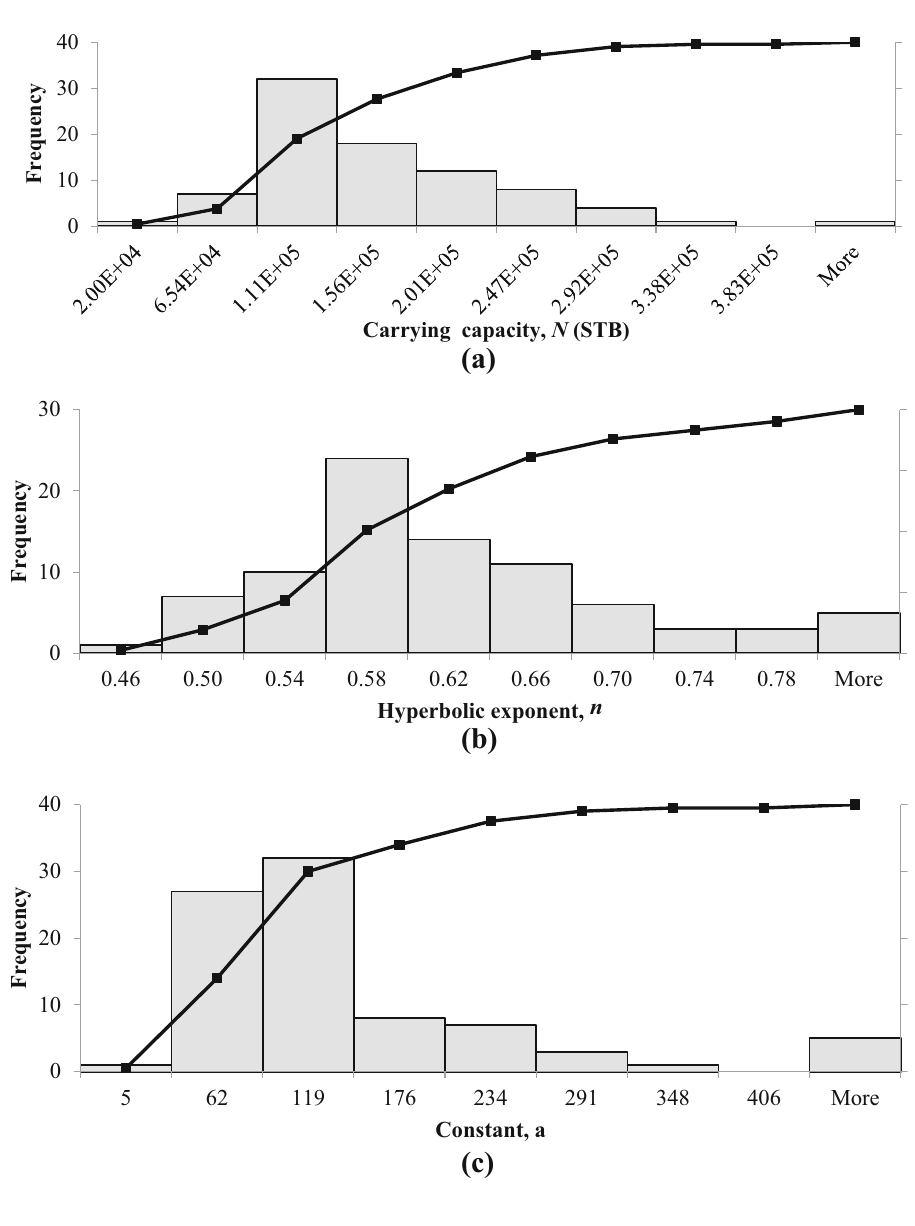
Fig. 6 Probability density function (PDF) and cumulative distribution function (CDF) obtained for the logistic growth model applied to the dataset. a PDF and CDF for the carrying capacity, b PDF and CDF for the hyperbolic exponent and c PDF and CDF for the constant